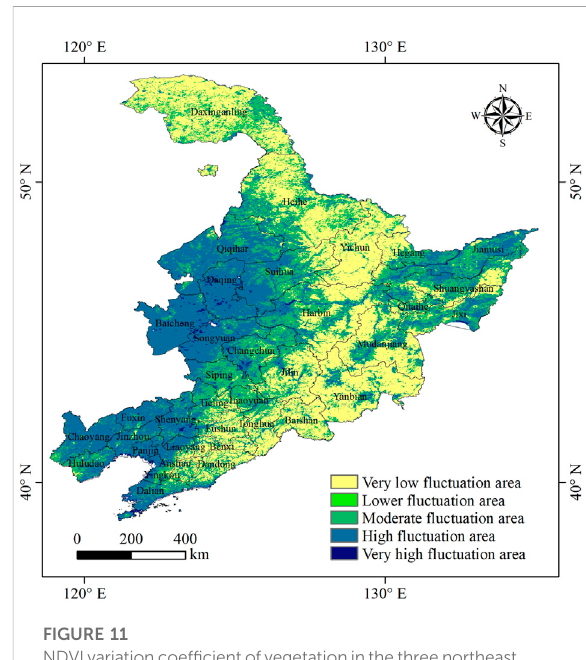
FIGURE 11 NDVIvariationcoef fi cientofvegetationinthethreenortheast